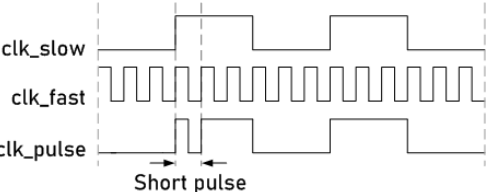
Figure 6. Waveform representation of the short pulse insertion in a clock